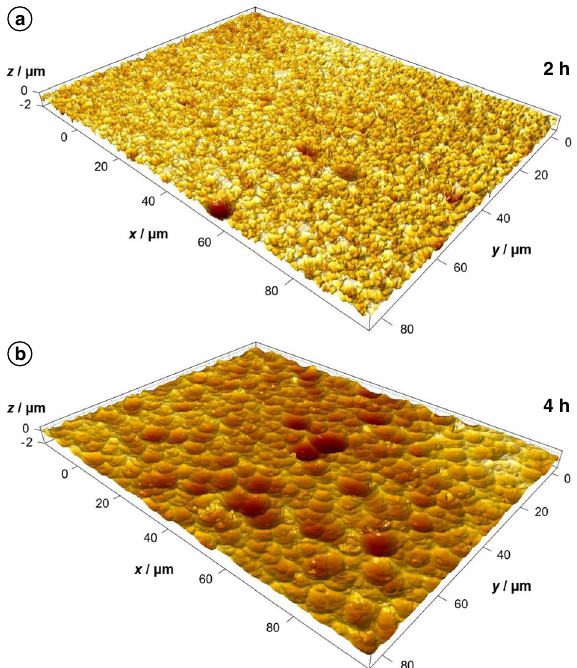
Fig. 5 High-resolution images of PET fi lms after reaction times of 2 and 4 h. The maps were recorded by confocal microscopy. a Topography after 2 h, capturing the fi rst occurrence of individual craters. b Topography after 4 h, showing complete coverage by craters.